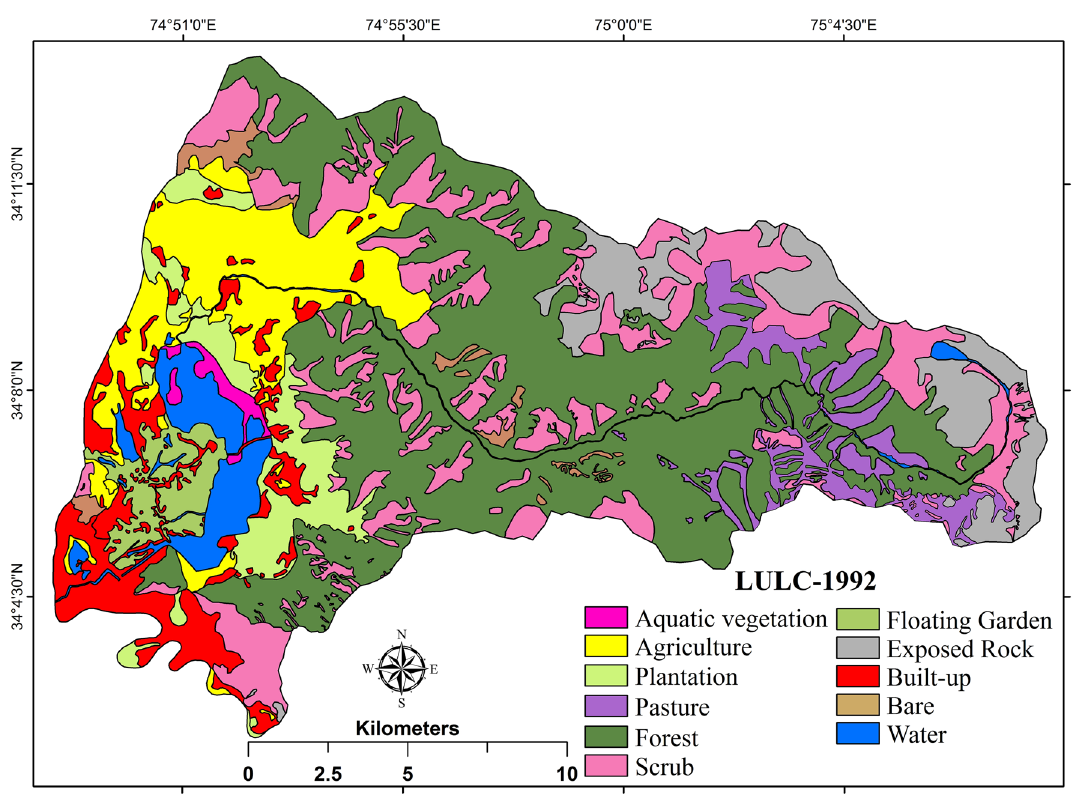
Fig. 4 LULC map of